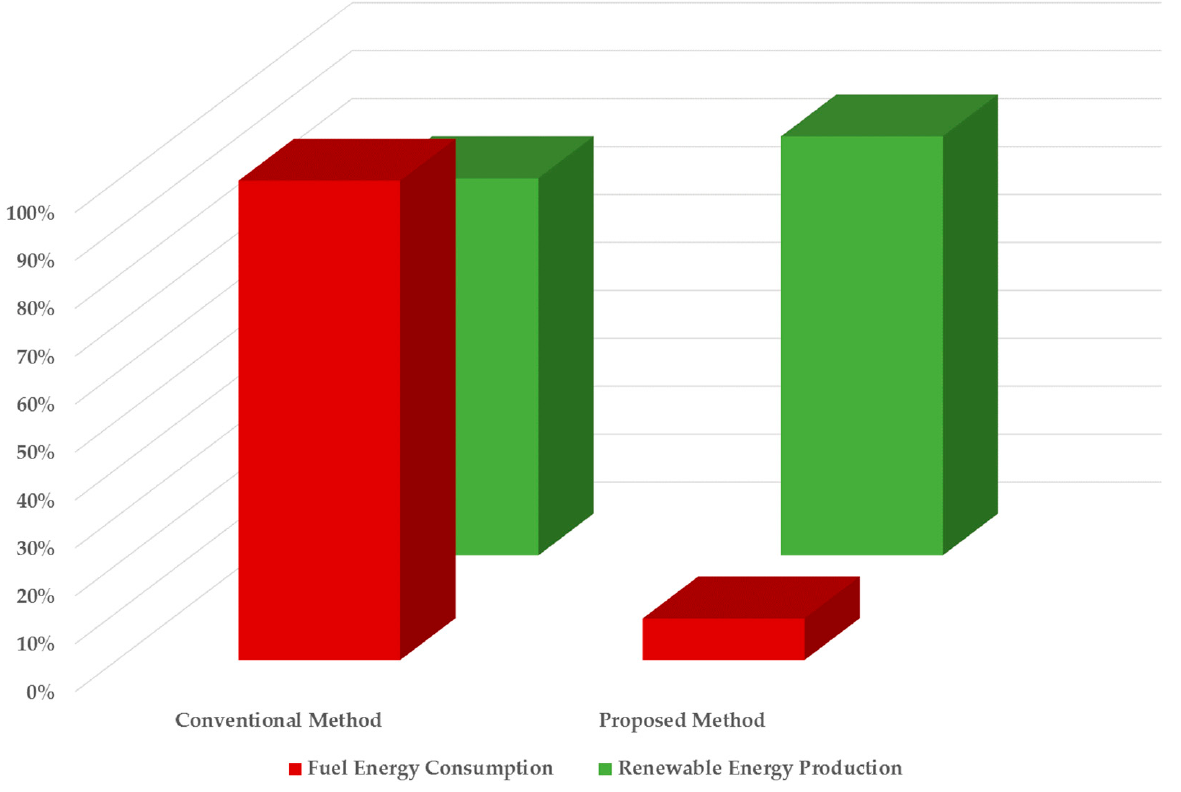
Figure 17. Comparison between fuel energy consumption and the renewable energy production in a conventional method and in the proposed one.